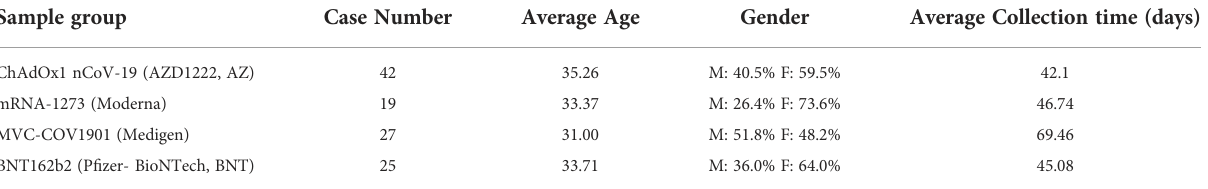
TABLE 1 Demographic characteristics of vaccinated